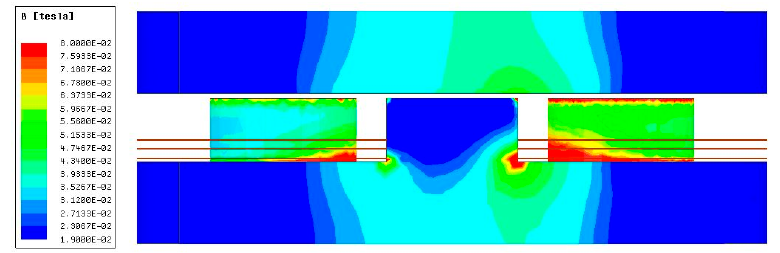
Figure 15. Flux density distribution by FEA 3D simulation. Table 5. Parameter design of the asymmetric resonant tank.